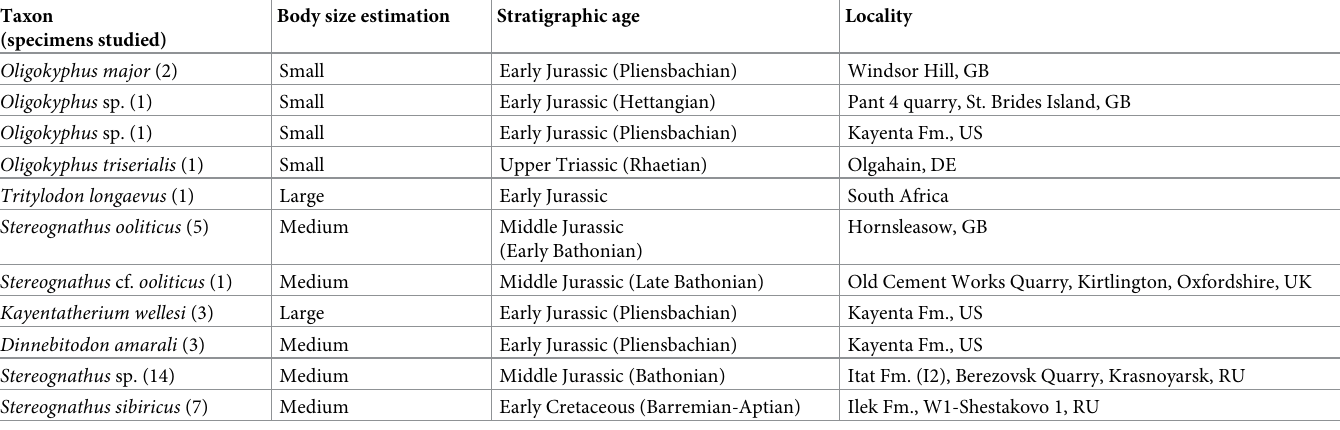
size was not available, on maximum upper or lower tooth width. We follow Gaetano et al. [10] known individuals. Skull lengths of 0–99 mm, 100–199 mm and 200 mm+ were used for our categories of small-, medium-, and large-bodied tritylodontids. Tritylodontids analysed in the small category are Oligokyphus sp. (GB), Oligokyphus sp. (US), Oligokyphus triserialis and Table 1. Summary table of the studied